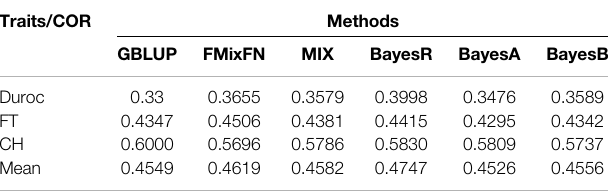
TABLE 2 | Comparison of predictive ability performances of six methods by using Duroc dataset and rice dataset. Traits/COR